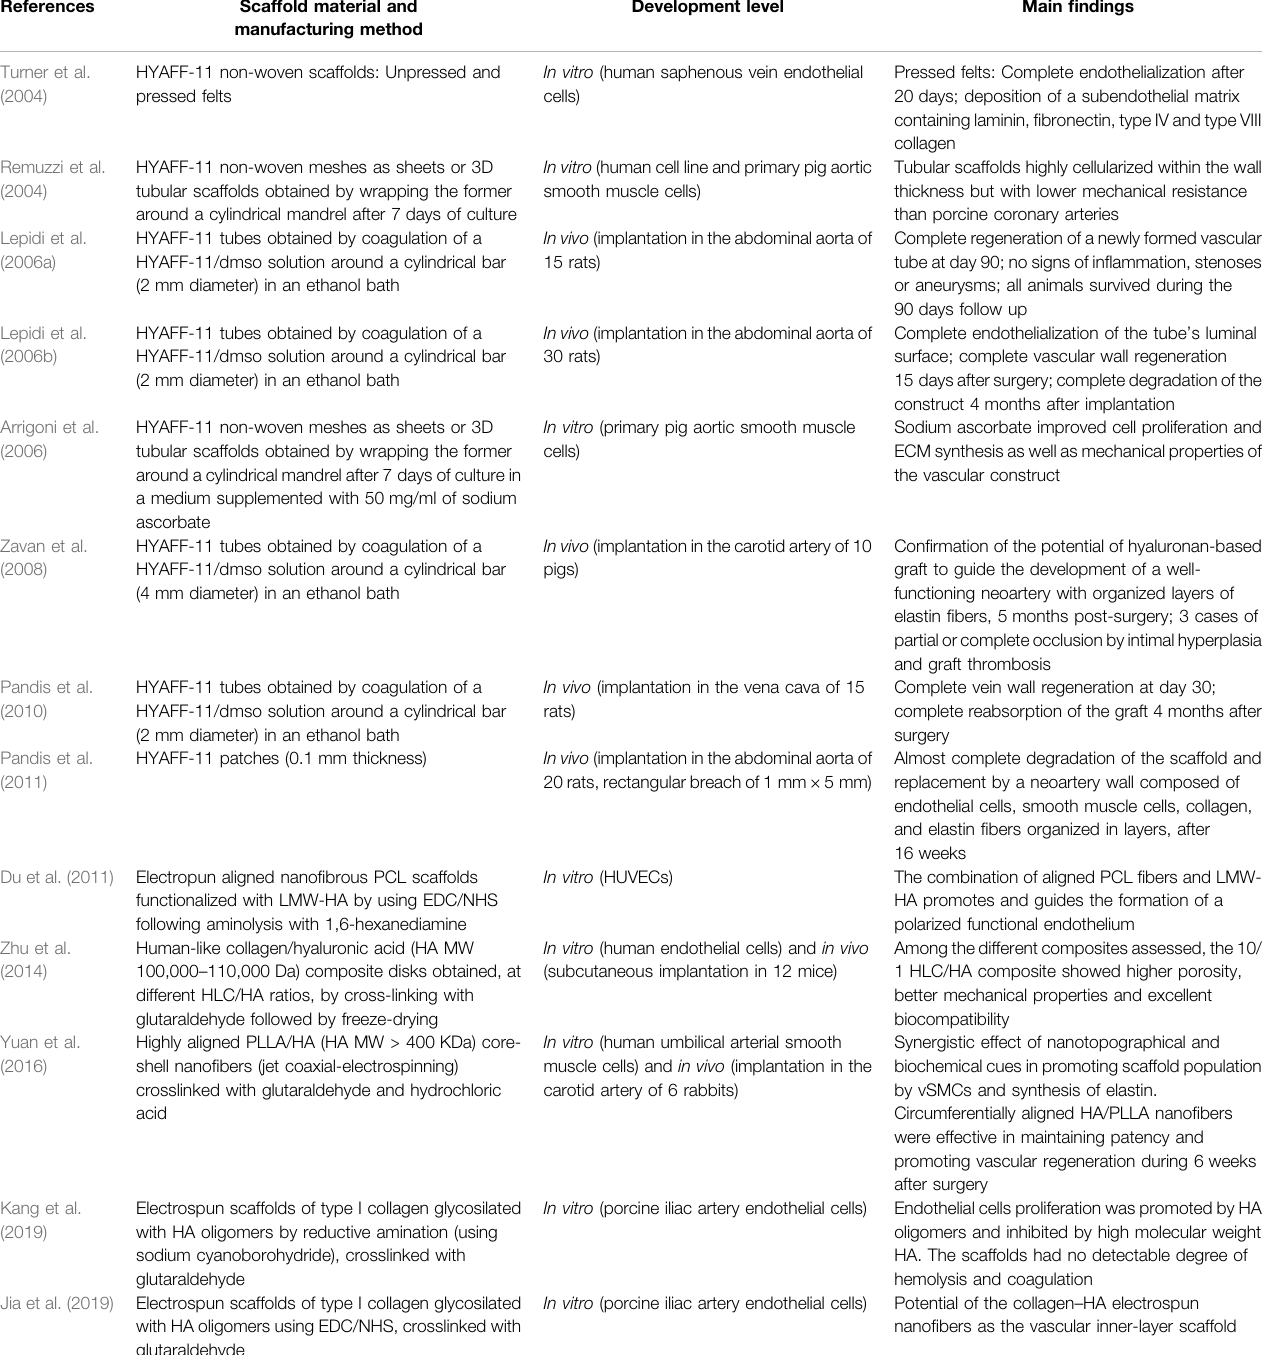
TABLE 1 | Hyaluronan-based vascular constructs for small-caliber artery